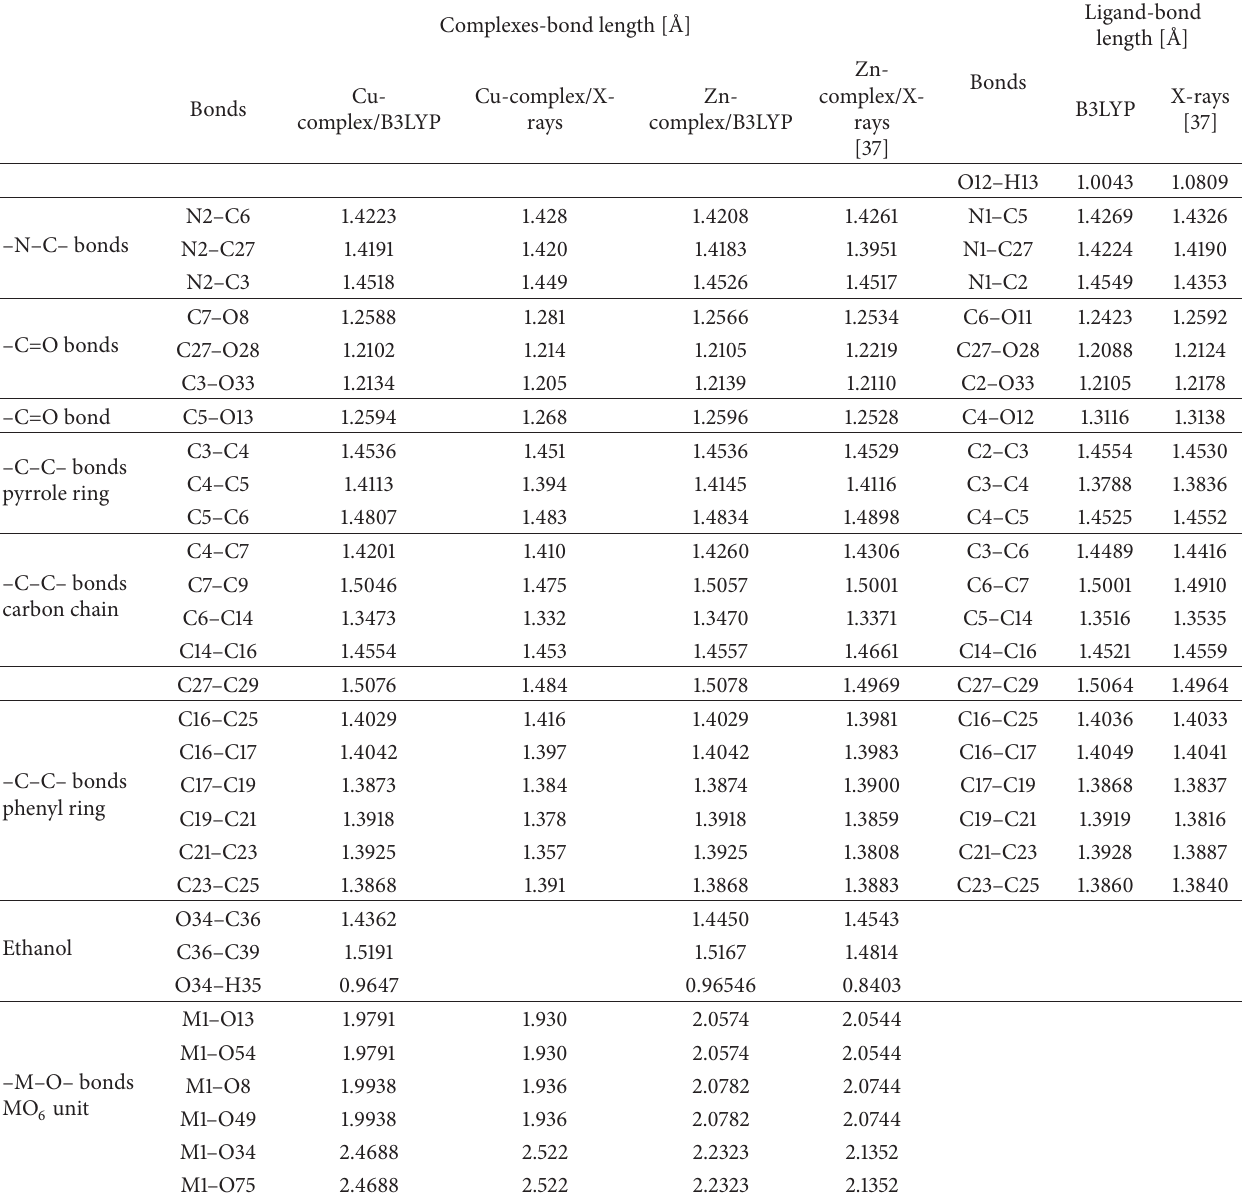
Table 3: Bond lengths in Angstroms of tetramic acid (TA) and Cu, Zn-complexes (Cu(TA-H + ) 2 (EtOH) 2 ), (Zn(TA-H + ) 2 (EtOH) 2 ) calculated by B3LYP method using the TZVP basis set. Atoms numbering refers to Figure 4.